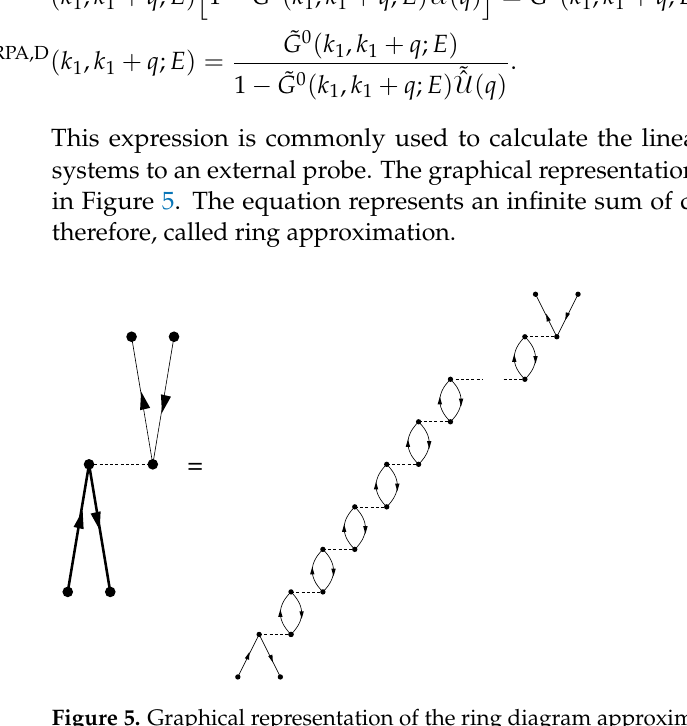
Figure 5. Graphical representation of the ring diagram approximation in